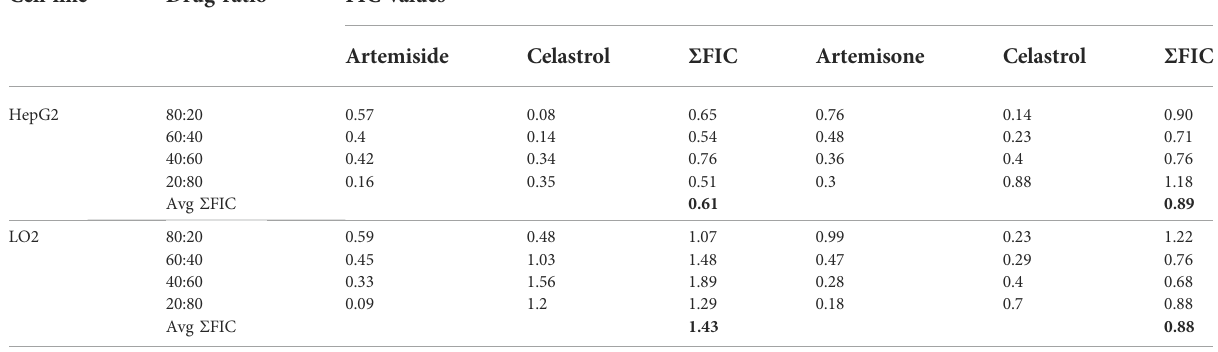
TABLE 5 Cytotoxicity FIC values for artemiside and artemisone in combination with celastrol.